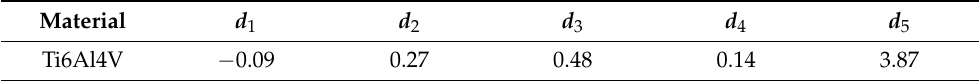
Table 6. Johnson–Cook failure parameters [33].